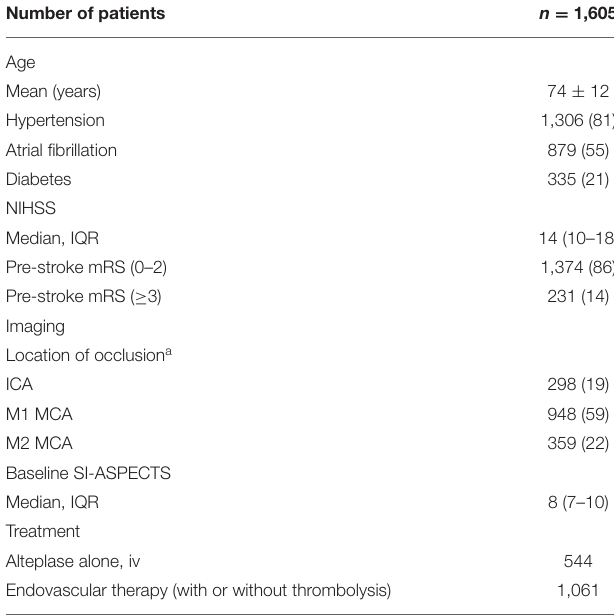
TABLE 1 | Baseline characteristics.